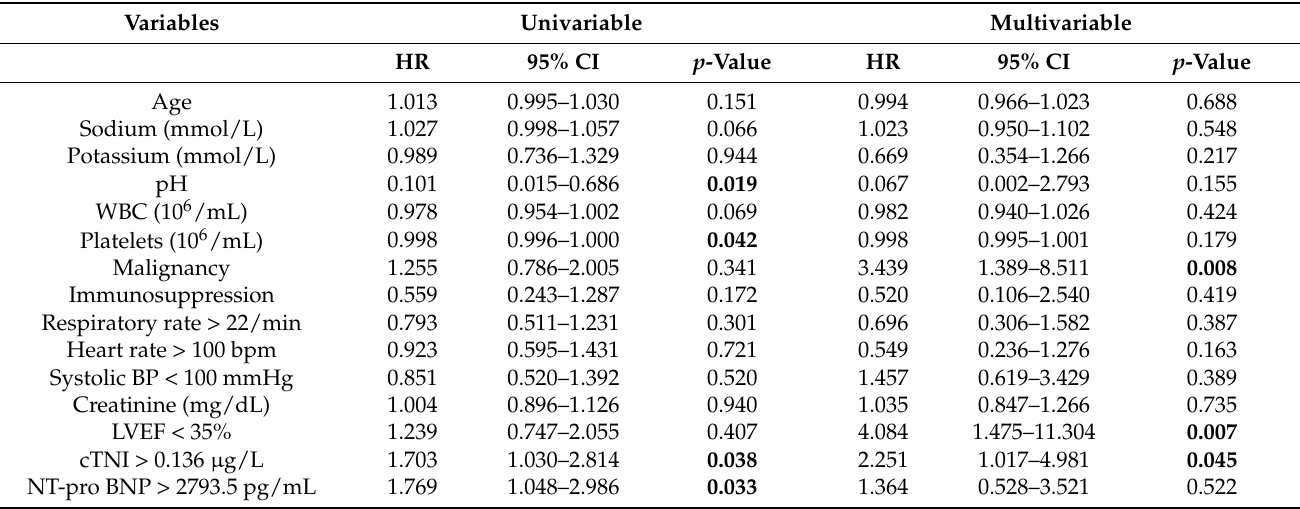
Table 6. Uni- and multivariable Cox regression analyses within the entire study